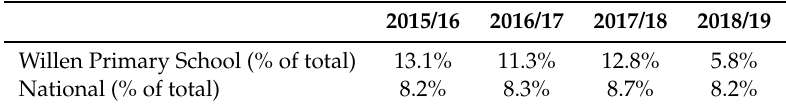
Table 9. Willen Primary School and National average persistent absenteeism